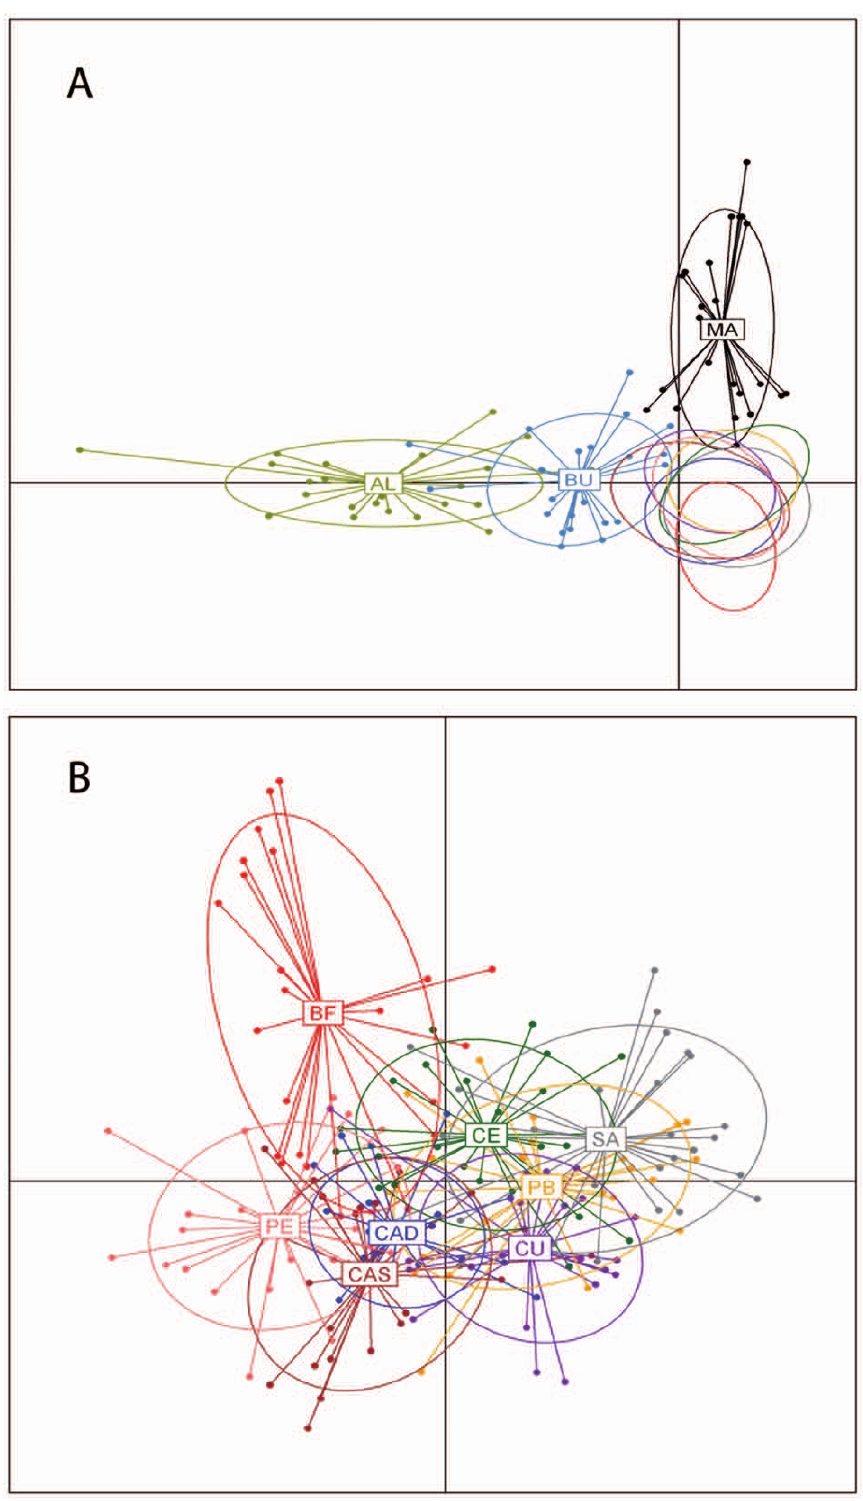
Figure 2. Plots of the first two axes obtained in the Discriminant Analysis of Principal Components using a combined dataset of microsatellite and mtDNA data. Labels were placed at the centre of dispersion of each group, further delineated by inertia ellipses. Dots represent individuals. A) Plot that included all populations. For the introduced populations, we only included ellipses to avoid cluttering, B) Plot including data of only the introduced populations, using the same colour codes as in (A). Population names abbreviated as in Table 1.